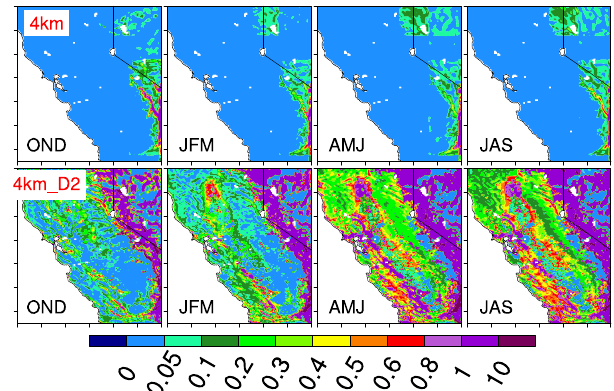
Figure 8. Mean dust emission rate (µgm − 2 s − 1 ) from the 4km and 4km_D2 runs.